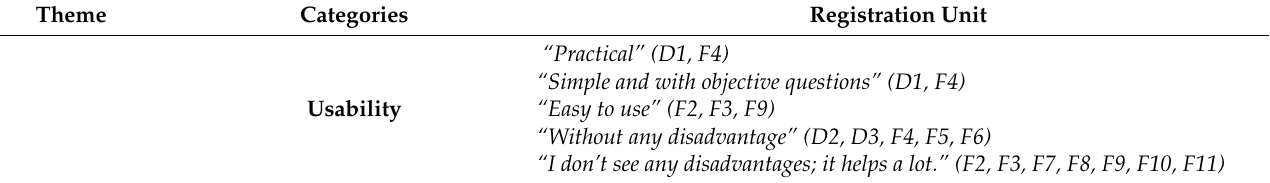
Table 3. Themes, categories, and registration units emerged from the content analysis of the open responses to the